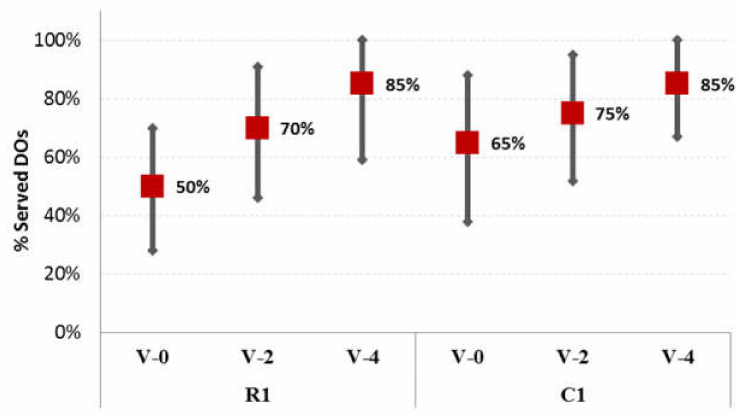
Figure 4. Average percentage of DO served vs. the available vehicles at depot per dataset (for the designation of the experimental instances see